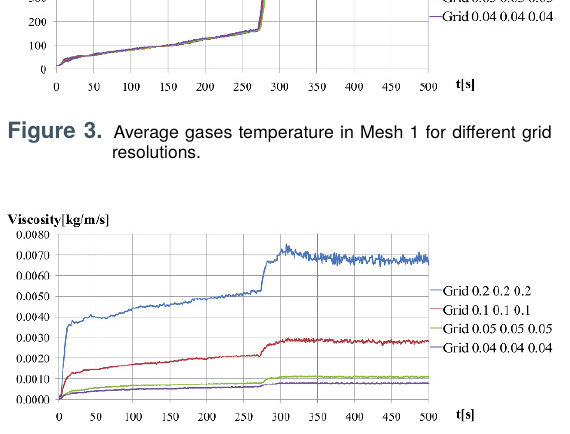
Figure 4. Average viscosity in Mesh 1 for different grid resolutions.